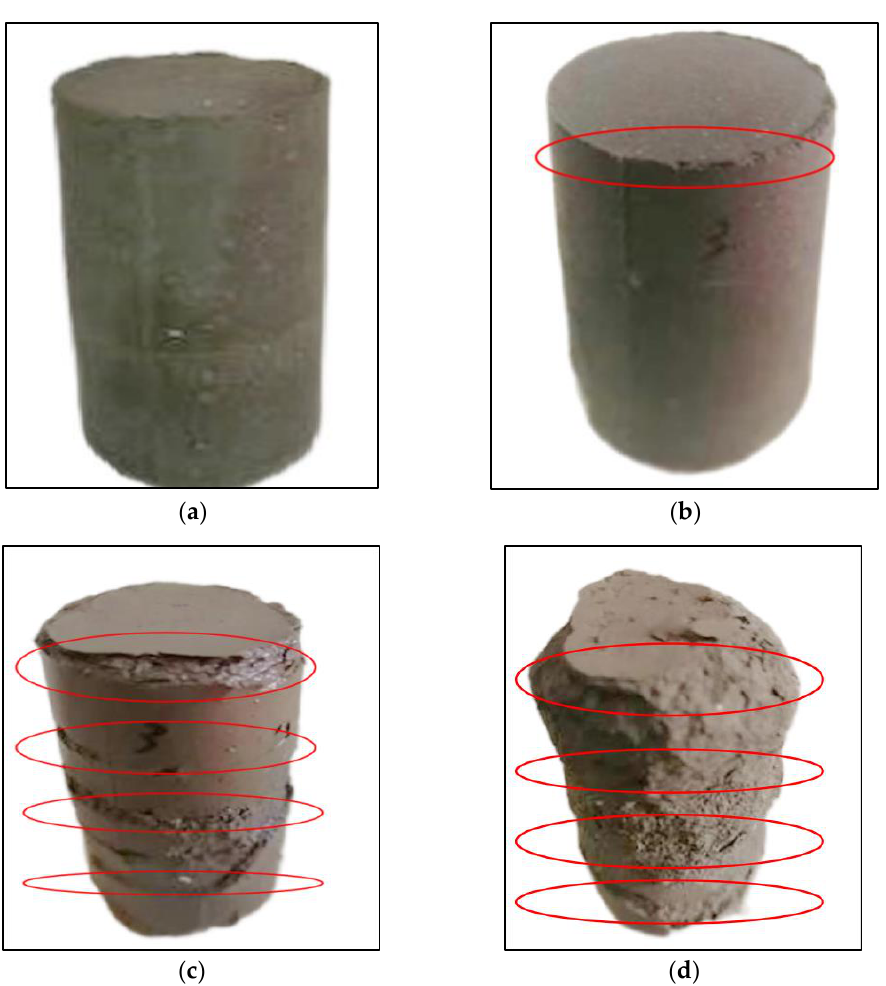
Figure 25. Morphology of solidified waste silt before and after drying and wetting cycles when w g